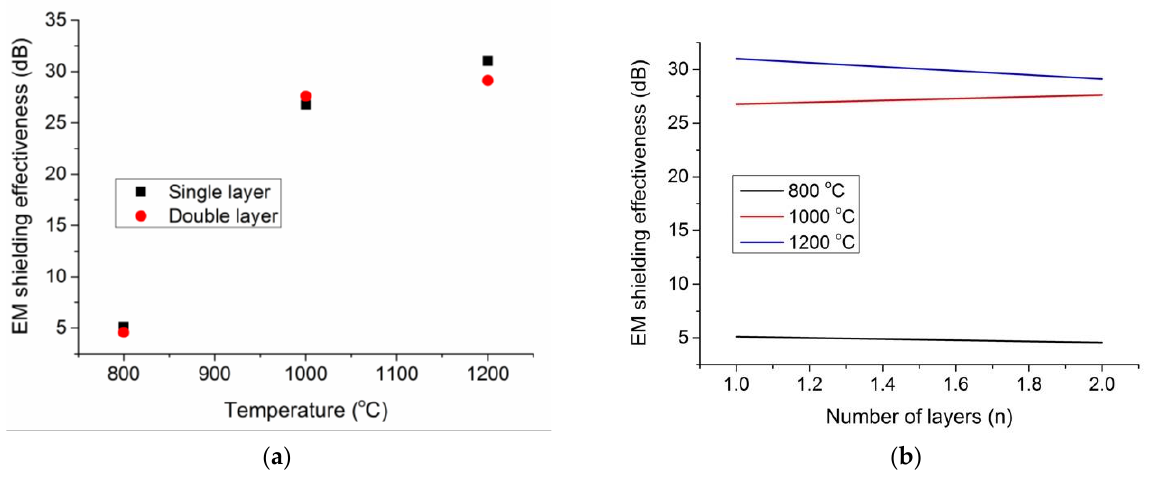
Figure 9. Electromagnetic shielding effectiveness at 2.45 GHz; ( a ) effect of carbonization temperature; and ( b ) effect of number of layers.